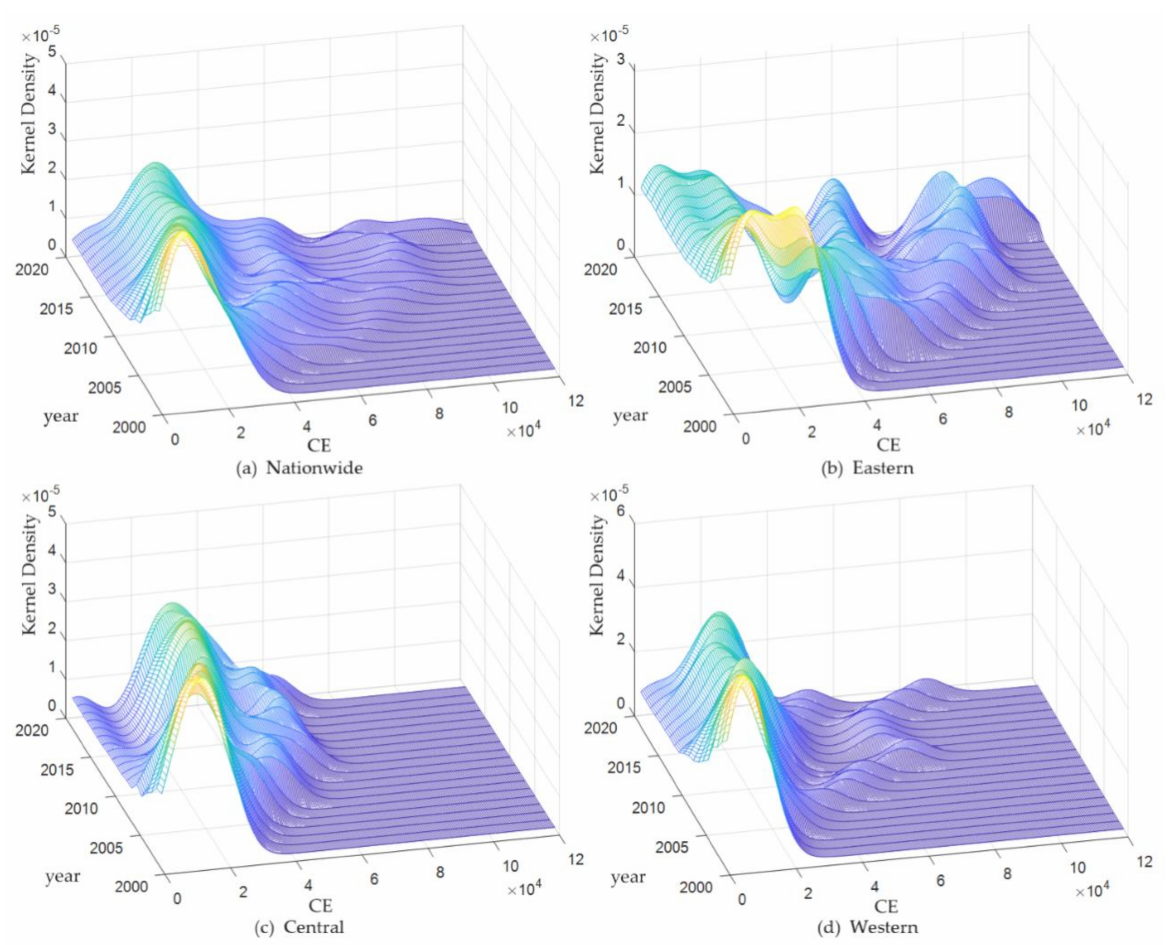
Figure 5. The dynamic evolution characteristics of CE in various regions, 2001–2019. Note: The graph is drawn by MATLAB software (version R2019b) based on the GTI calculation